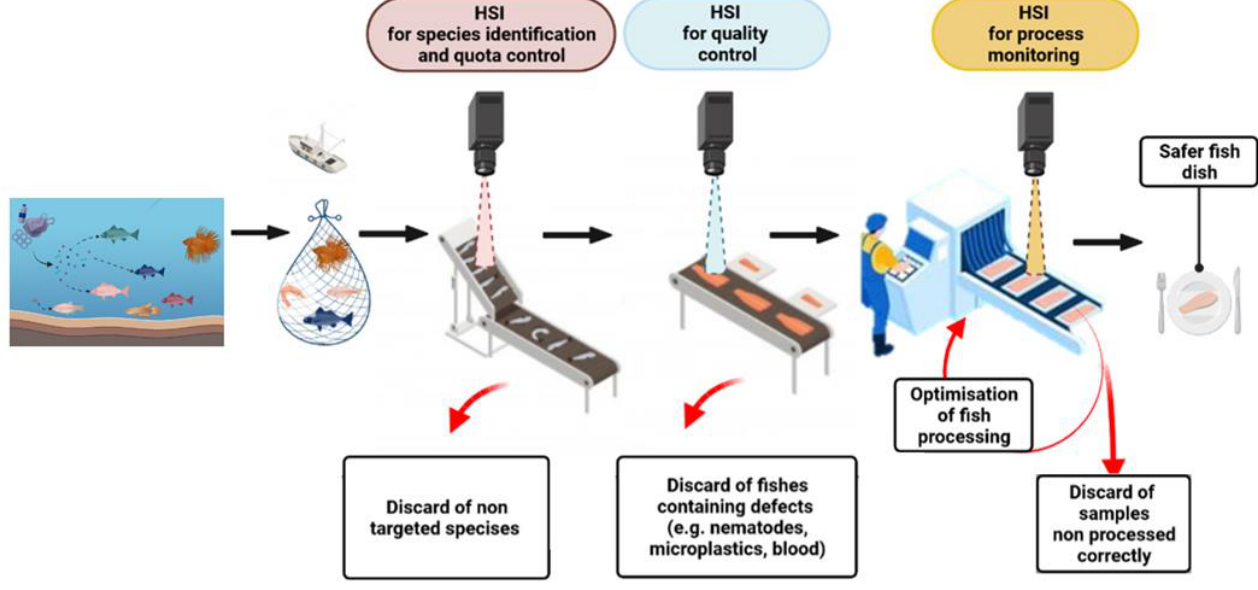
Figure 1. Examples of applications of hyperspectral imaging in the seafood sector.